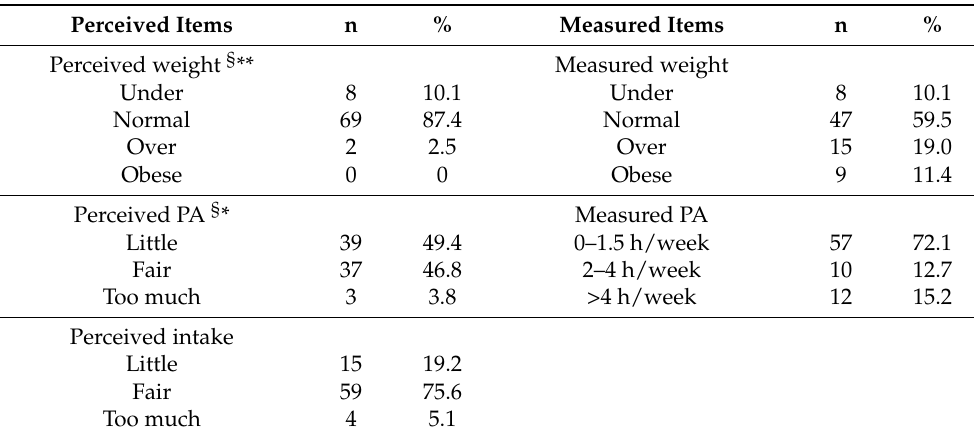
Table 4. Parent’s perceptions frequencies of children’s weight status, intake and